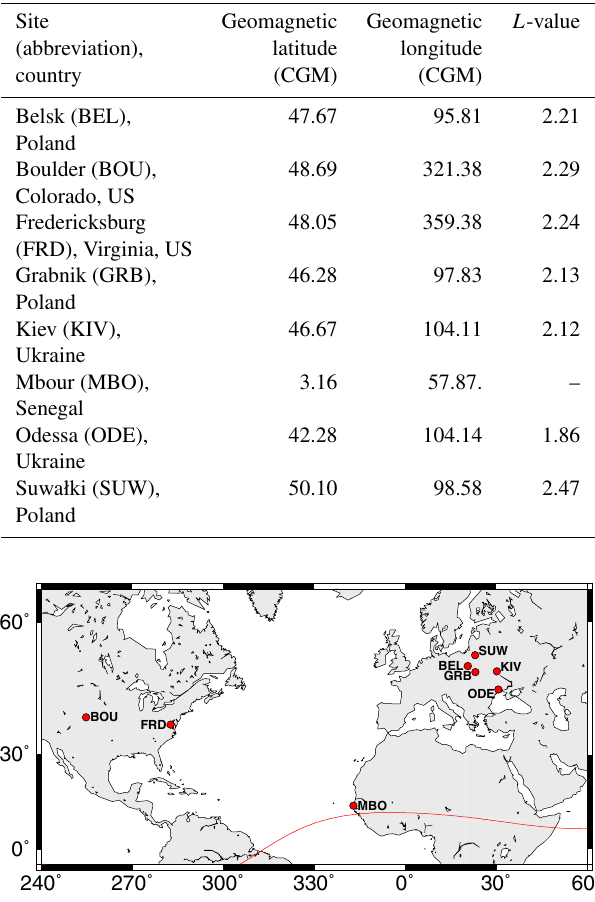
Figure 3. Map with site locations. The red line marks the magnetic Equator following Emmert et al.